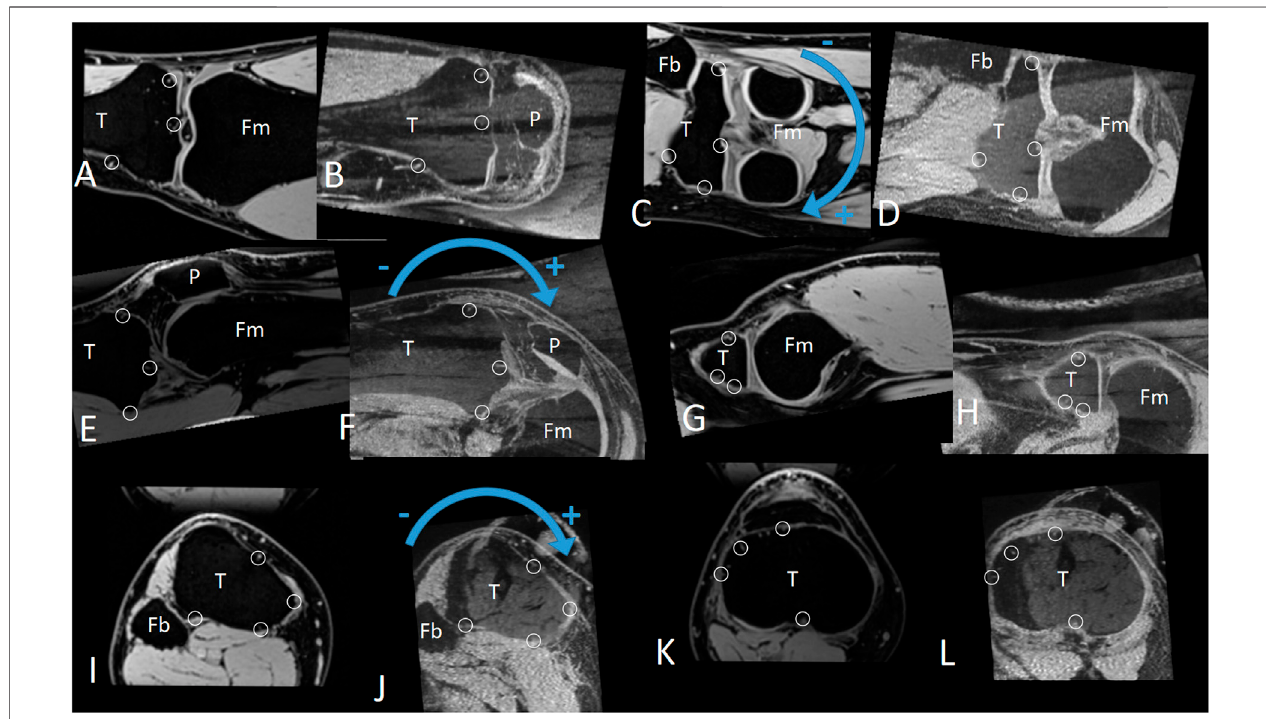
FIGURE 1 | The positive and negative directions of the coronal, sagittal, and horizontal plane rotation, as well as the characteristic area frame (CAF, composed by multiple characteristic areas). (A – D) Coronal plane. (E – H) Sagittal plane. (I – L) Horizontal plane. Small circles: Subcortical vascular segment(SCVS) selected as the characteristic area. T: tibia. P: patella. Fm: femur. Fb: fi bula.